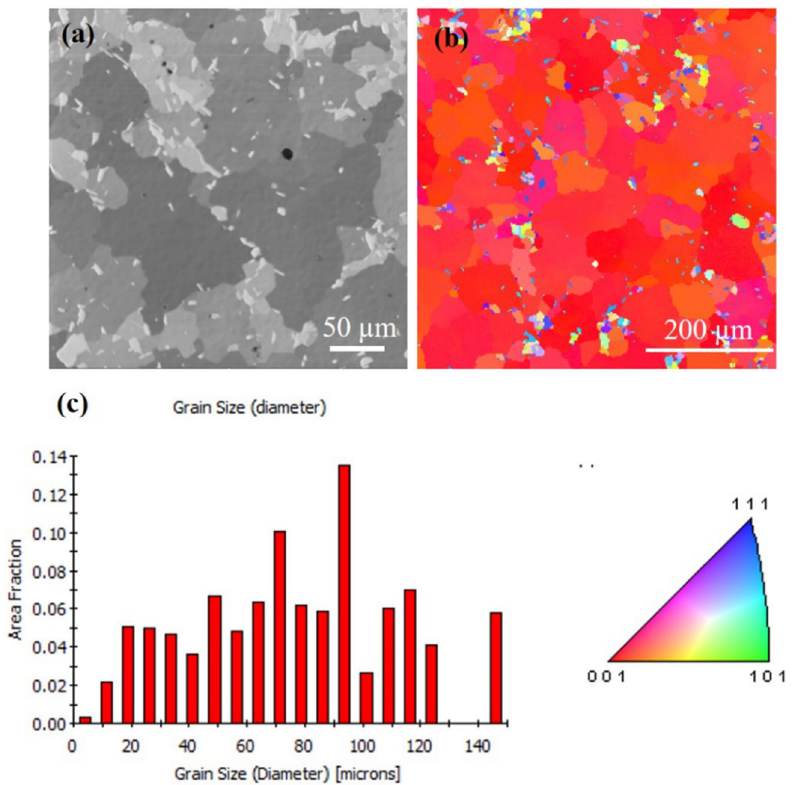
Figure 7. Grain morphologies for the Cu film at 350 °C for an hour. ( a ) FIB top-view image. ( b ) EBSD orientation image. ( c ) Grain size distribution of the grains in pole Figure 7b.